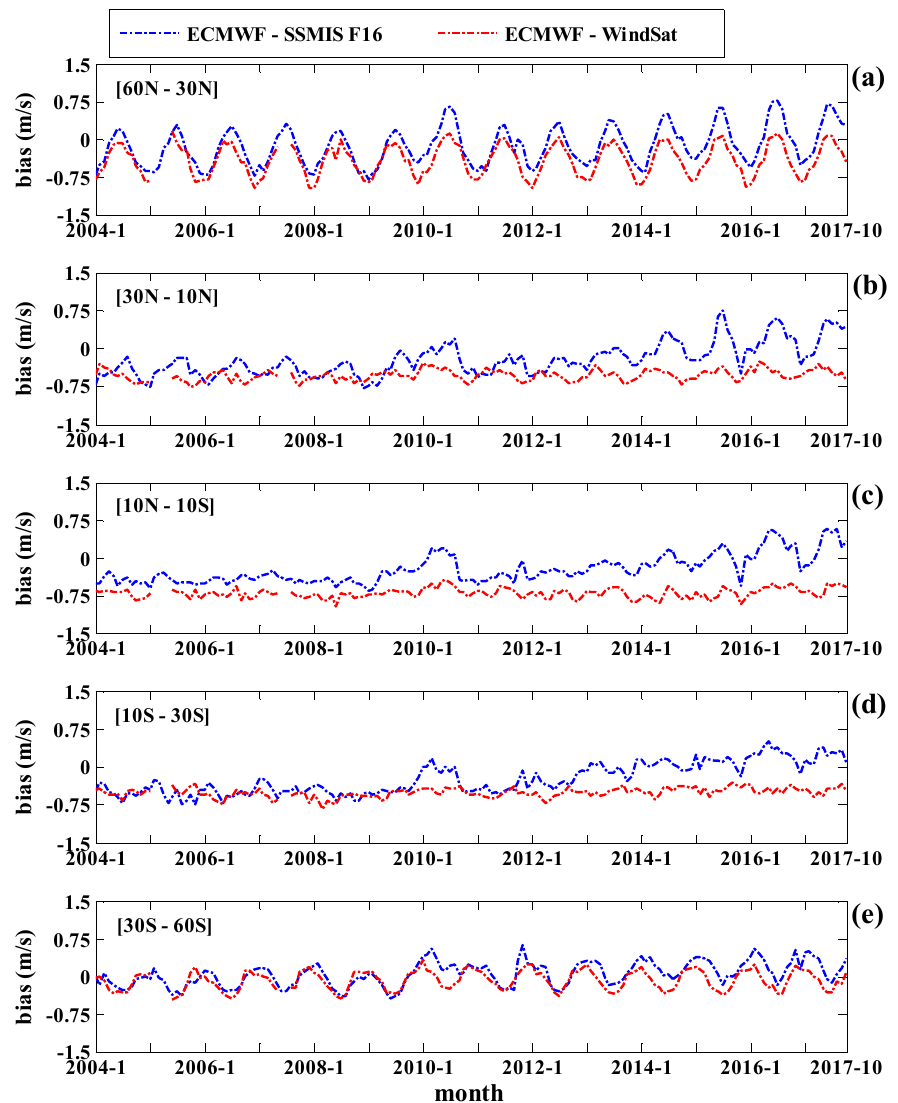
Figure 7. Monthly averaged wind speed differences for ECMWF–WindSat (red dashed line) and ECMWF–SSMIS F16 (blue dashed line) from January 2004 to October 2017 in five latitudinal bands. ( a ) 30°N–60°N; ( b ) 10°N–30°N; ( c ) 10°S–10°N; ( d ) 10°S–30°S; and ( e ) 30°S–60°S.